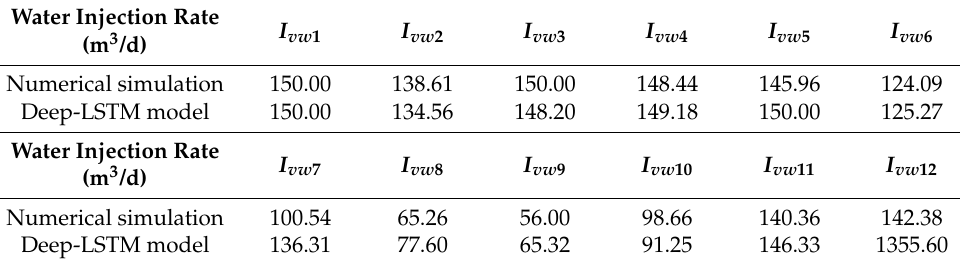
Table 8. Comparison of optimization results of 12 water injection wells.